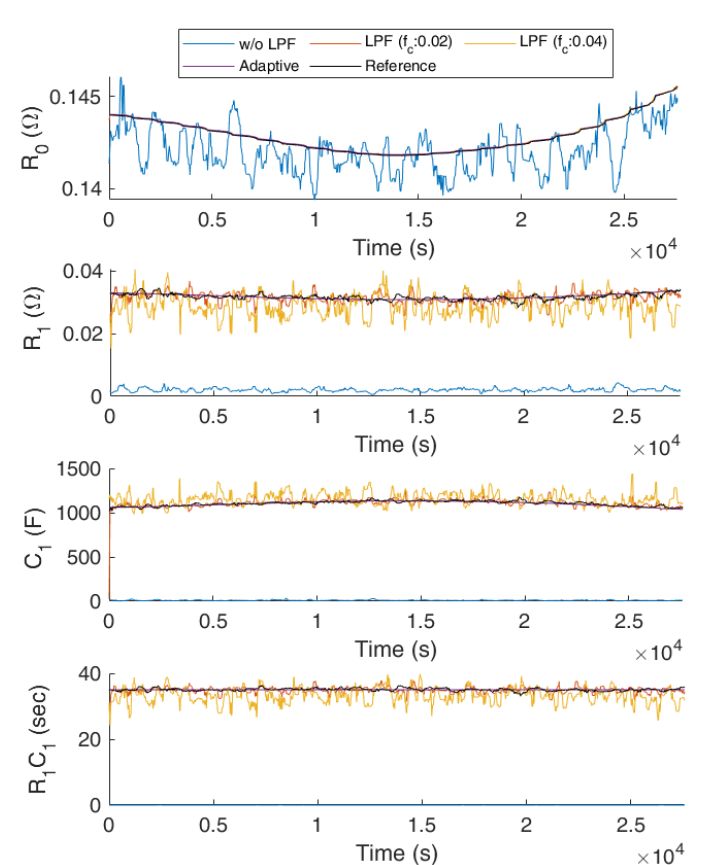
Figure 6. Parameter identification result